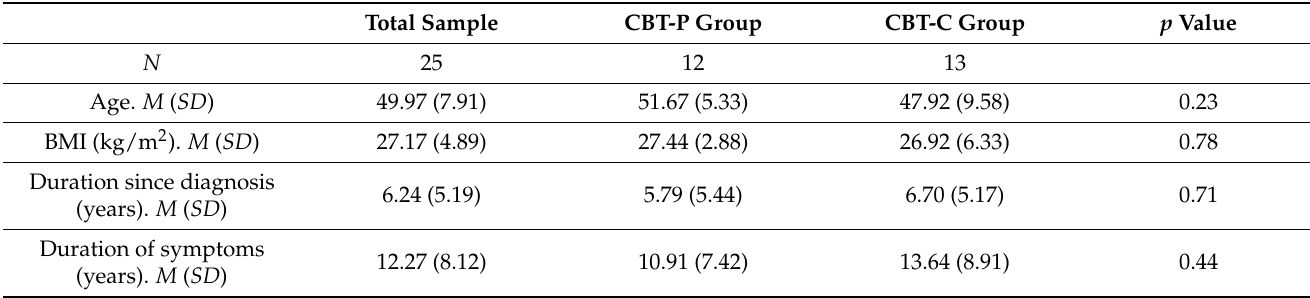
Table 2. Demographic and clinical features of fibromyalgia